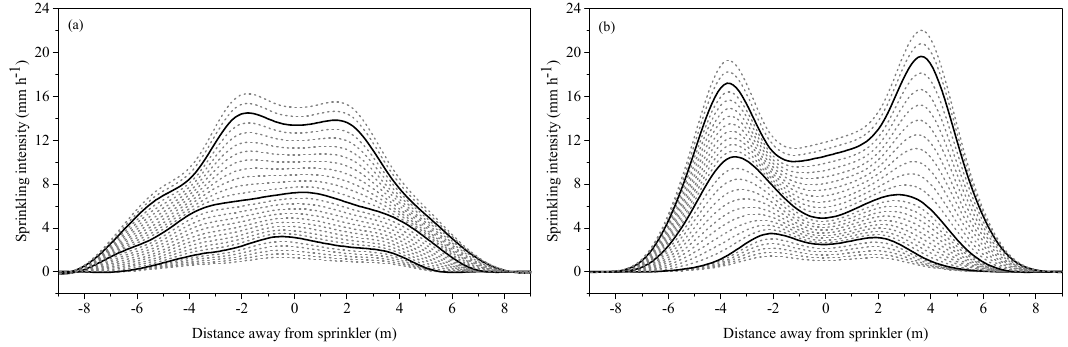
Figure 4. The estimated average radial application patterns for the unmeasured nozzles equipped in